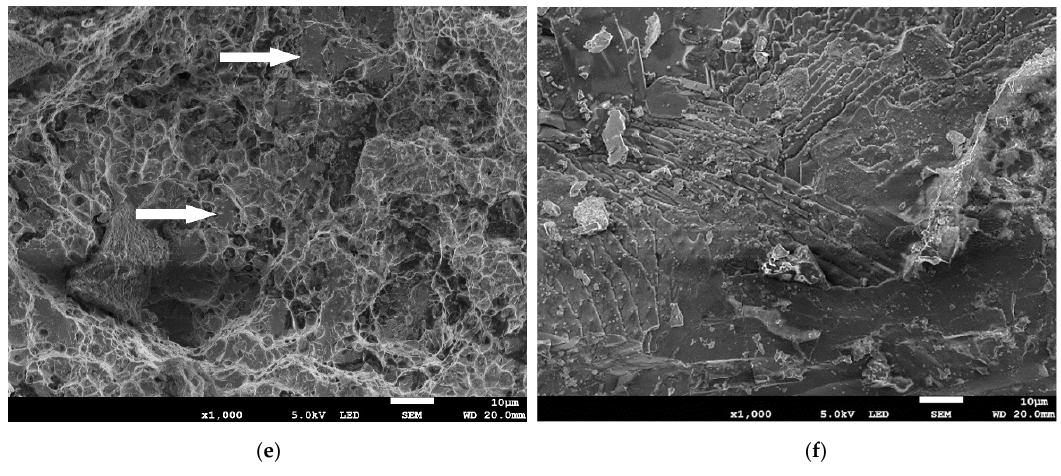
Figure 10. Fracture surfaces of specimens after tensile tests: ( a ) specimen made using A wire in delivery condition; ( b ) specimen made using B wire in delivery condition; ( c ) specimen made using A wire stored in GWS; ( d ) specimen made using B wire stored in GWS; ( e ) specimen made using A wire stored in MAB; ( f ) specimen made using B wire stored in MAB.